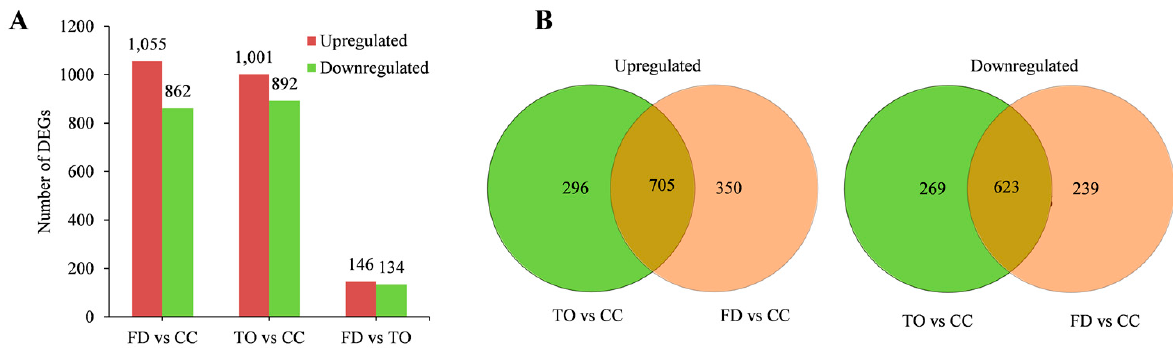
Figure 3. DEGs in the stem of three rootstocks. ( A ): The numbers of upregulated and downregulated DEGs in the indicated comparisons. ( B ): Venn diagrams show the overlapped DEGs in the TO and FD rootstocks compared with the CC rootstocks .